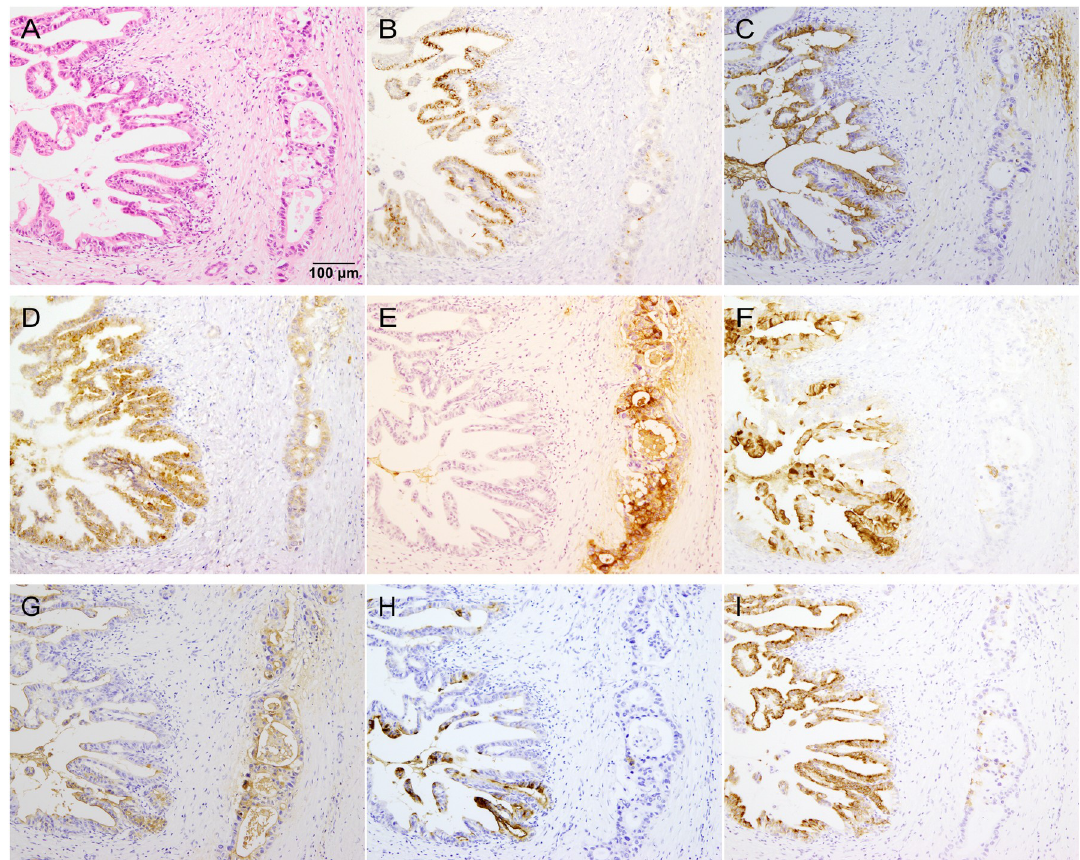
Fig 2. Representative microscopic images of immunohistochemistry and lectin-histochemistry in PDAC tissues. Middle-power view of tissues stained with (A) HE, (B) β 3Gn-T6, (C) T antigen (PNA), (D) Tn antigen (LU-35), (E) 6-sulfo N -acetyllactosamine on extended core 1 O -glycan (MECA-79), (F) sLeX (CSLEX1), (G) sLeX (HECA-452), (H) sLeX on core 2 O -glycan (ST-439) and (I) MUC5AC. All these sections show the same region of PDAC tissue. In the left half of the panel, intraductal spreading of adenocarcinoma cells is seen, and invasive adenocarcinomas are present in the right half. All these antigens are expressed to various degrees of heterogeneity in the adenocarcinoma cells, even within the same case. Different staining patterns of sLeX are observed depending on the specificity of the antibodies used as described in the main text